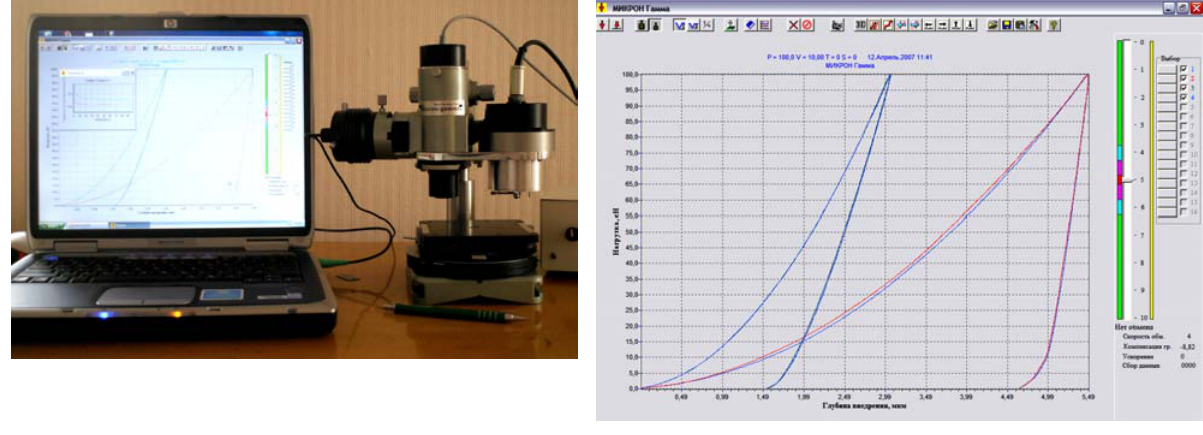
Fig 2. Micron GAMA nanotester